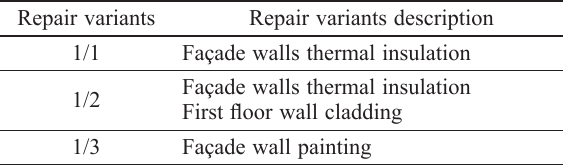
Table. 4. Façade wall repair variants of one building